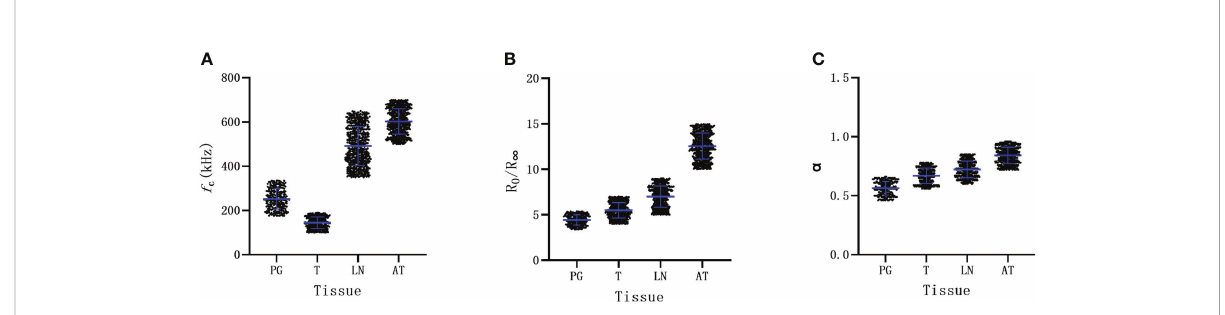
FIGURE 2 The distribution of Bioelectrical Impedance Spectroscopy parameters of different tissue. (A) parameter of f c . (B) parameter of R 0 /R ∞ . (C) parameter of a . PG parathyroid gland, T thyroid, LN lymph node, AT adipose